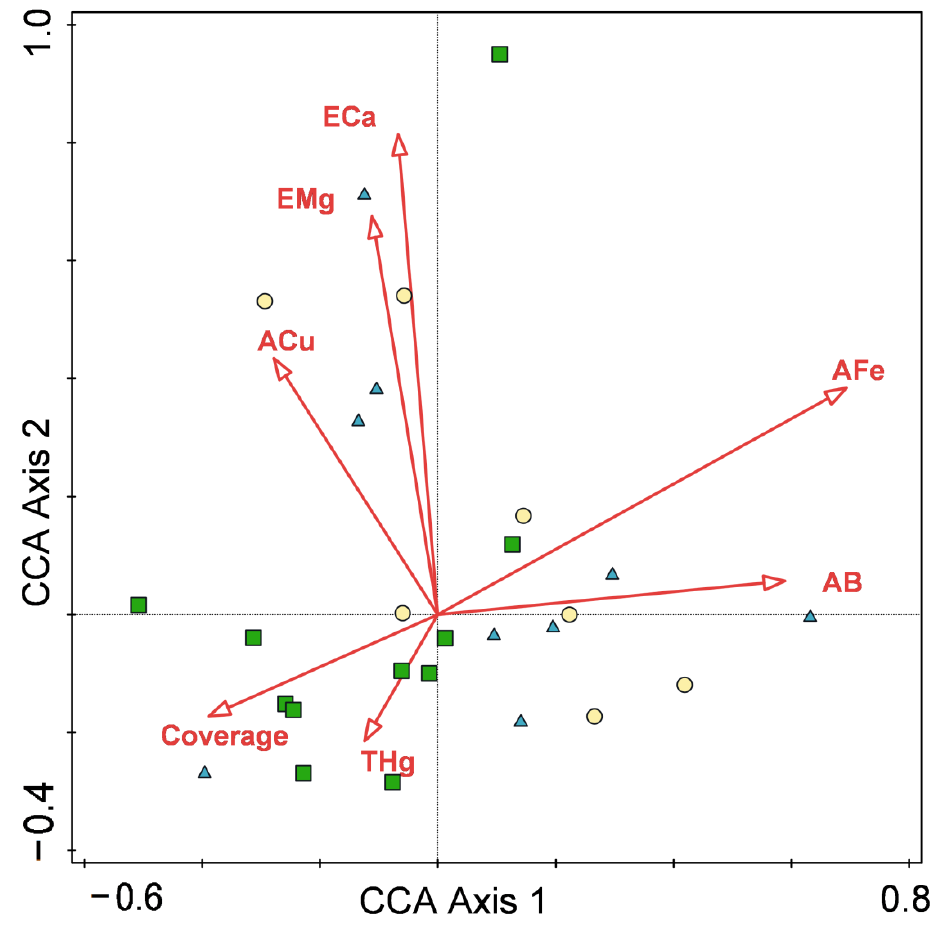
Figure 4. Ordination biplot showing the first two axis results from canonical correspondence analysis (CCA) of natural forest (filled squares), abandoned fallows (filled circles) and planted forest (filled triangles).